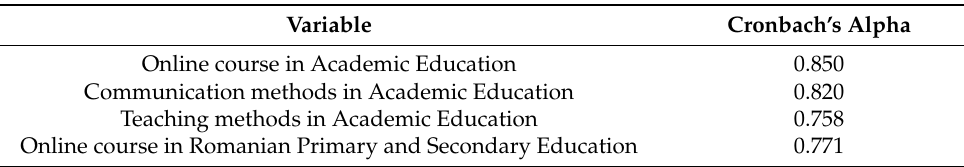
Table 1. Summary of processed cases of variables: reliability